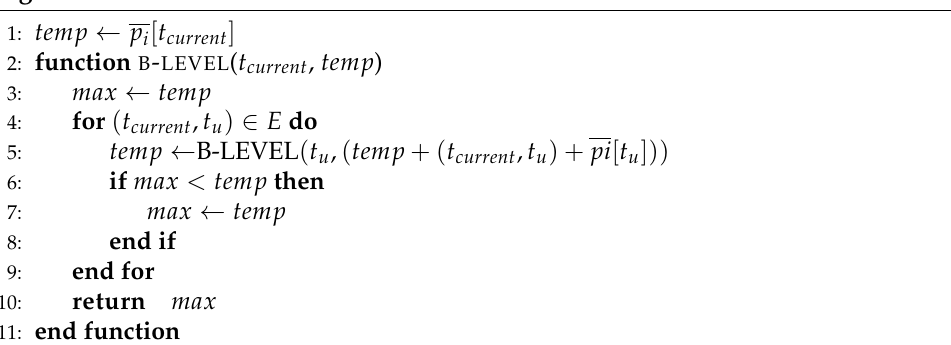
Algorithm 11 b-level recursive